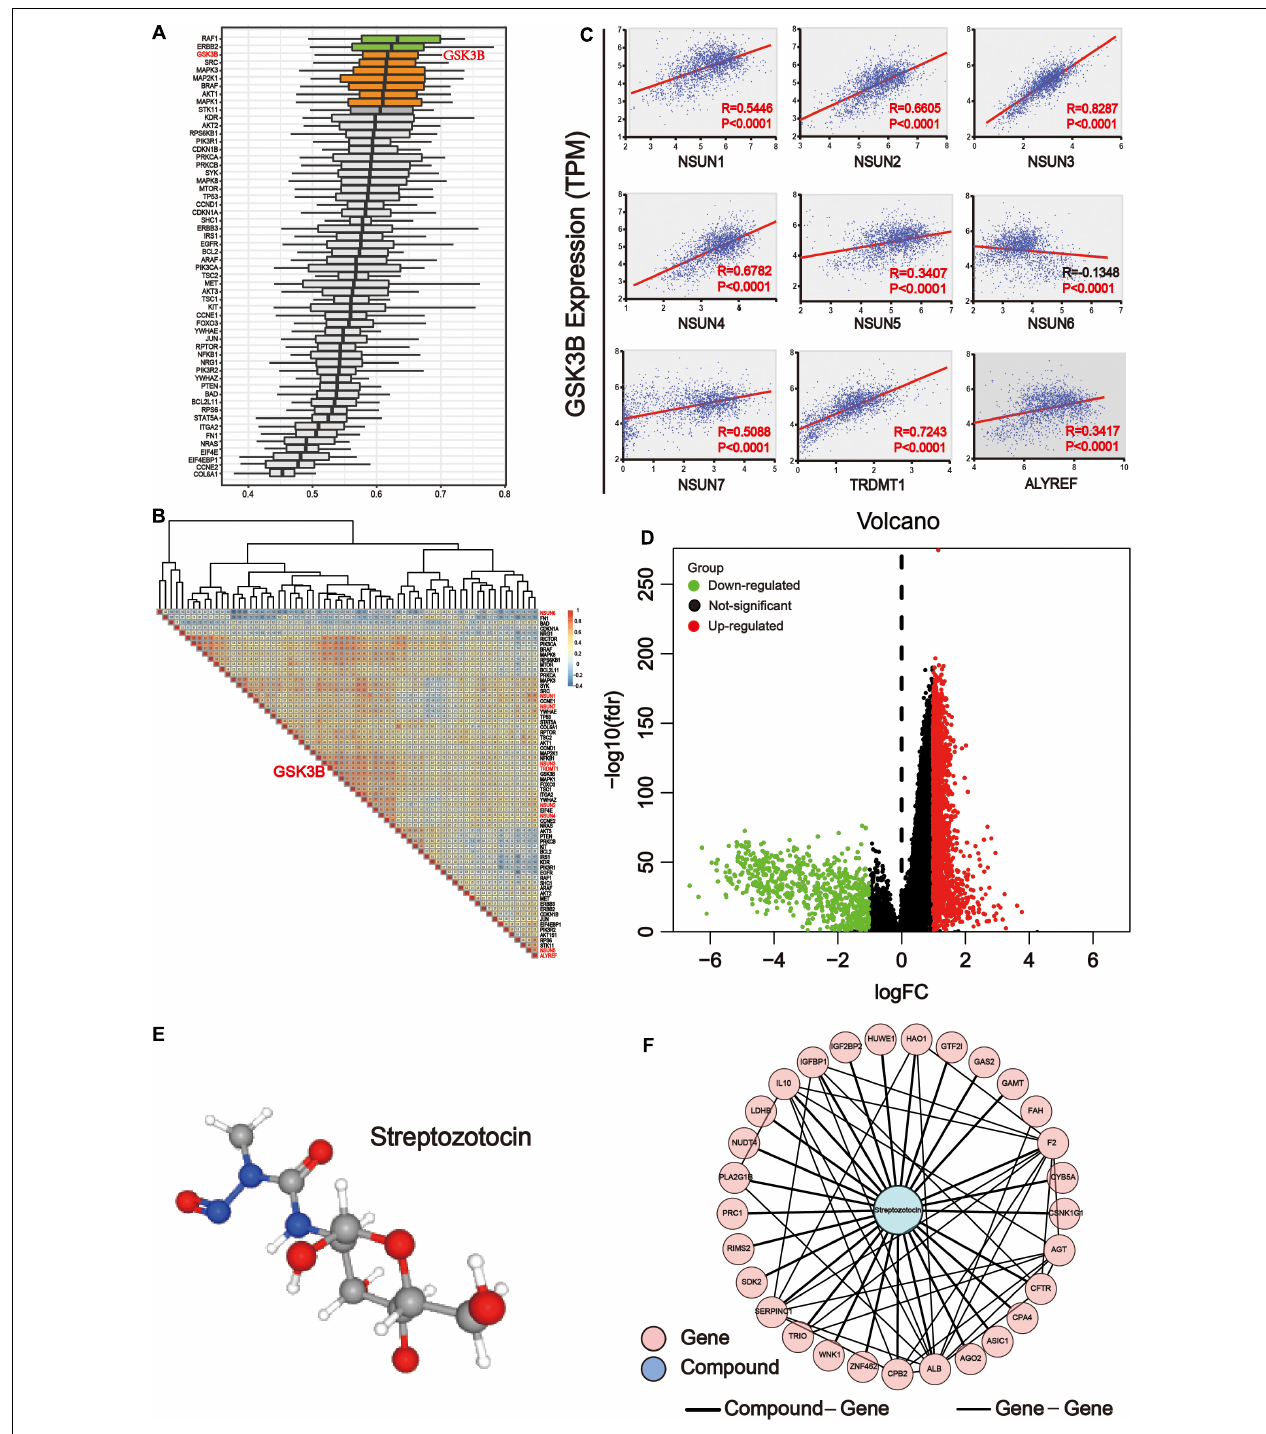
FIGURE 8 | GSK3B is closely related to m 5 C regulators. (A) The importance of key proteins of the downstream pathway in the three major categories of Gene Ontology (GO), including biological processes, cell components, and molecular functions. The X axis is the score obtained by comprehensively considering the weight of the three categories of GO. The higher the score, the more important the protein is involved in the GO project. (B) Co-expression analysis of m 5 C differential proteins of the ErbB and PI3K–Akt pathways. The co-expression scores of related genes were displayed. The color intensity reflects the reliability of co-expression; meanwhile, red and blue indicate high correlation and low correlation, respectively. (C) Correlation analysis between writers and reader protein of m 5 C with GSK3B . There were significant differences between GSK3B and all genes. (D) The samples were grouped according to the median expression of GSK3B gene, and differential expression analysis was performed. (E) 3D structure of streptozotocin. (F) PPI network analysis between the common genes between streptozotocin.